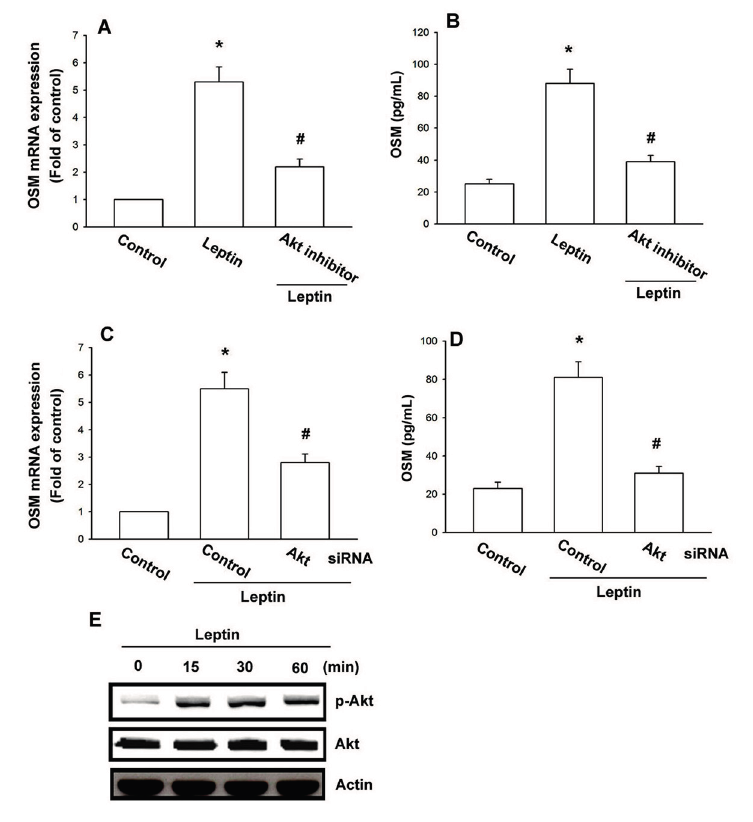
Figure 4. Leptin increases OSM expression through the Akt pathway in osteoblasts. ( A – D ) Osteoblasts were pretreated with Akt inhibitor (10 µM) for 30 min or transfected with Akt siRNA for 24 h followed by stimulation with leptin (30 nM) for 24 h; OSM expression was examined by the qPCR and ELISA assay; ( E ) Osteoblasts were incubated with leptin (30 nM) for the indicated time intervals, Akt phosphorylation was examined by western blotting. Results are expressed as the mean ± SEM; * p < 0.05 as compared with the basal level; # p < 0.05 as compared with the leptin-treated group.